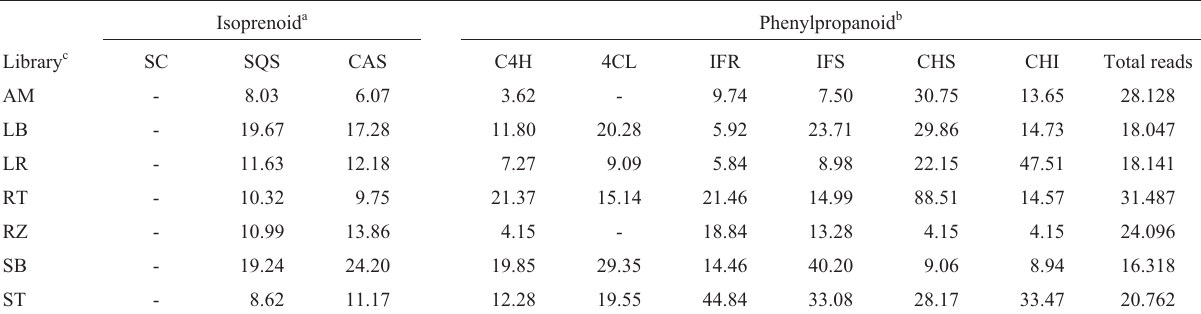
Table IV - Gene expression pattern of tissues from sugarcane variety SP 80 – 3280. Values represent the ratio of enzyme related transcript abundance (x 10 5 ) multiplied by the total reads of the library in the SUCEST